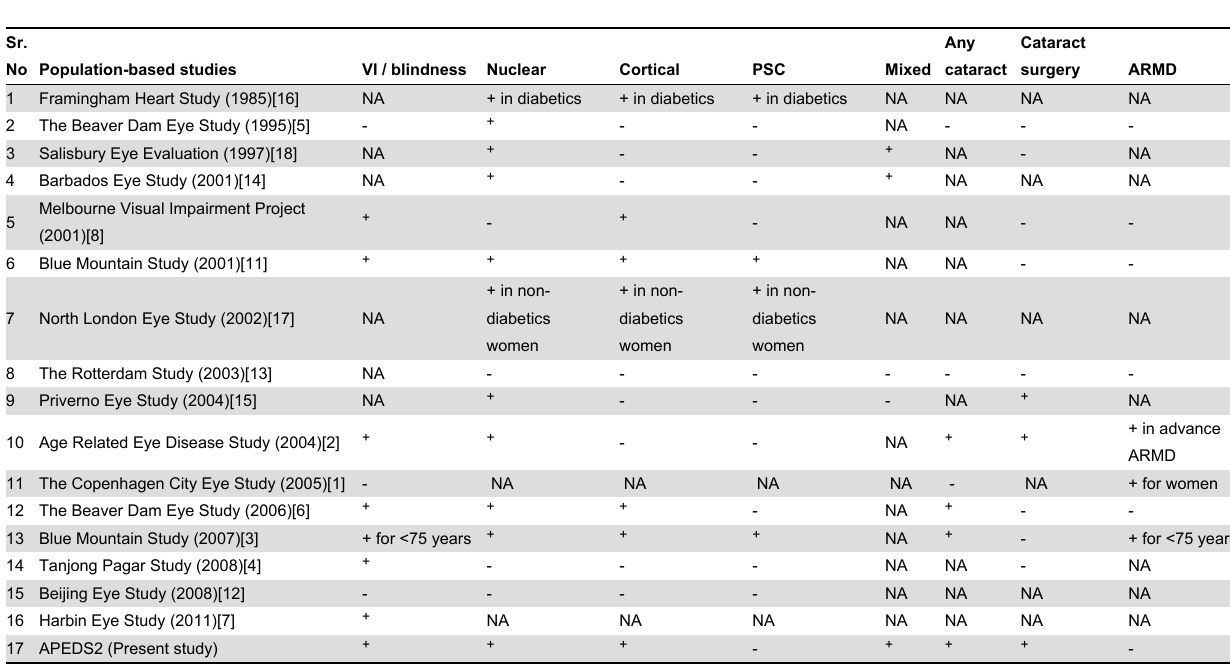
Table 7. The risk factors for mortality across different studies.